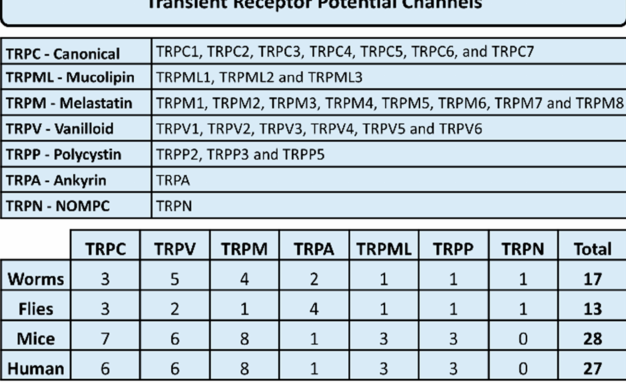
Figure 2. Classification of transient receptor potential ion